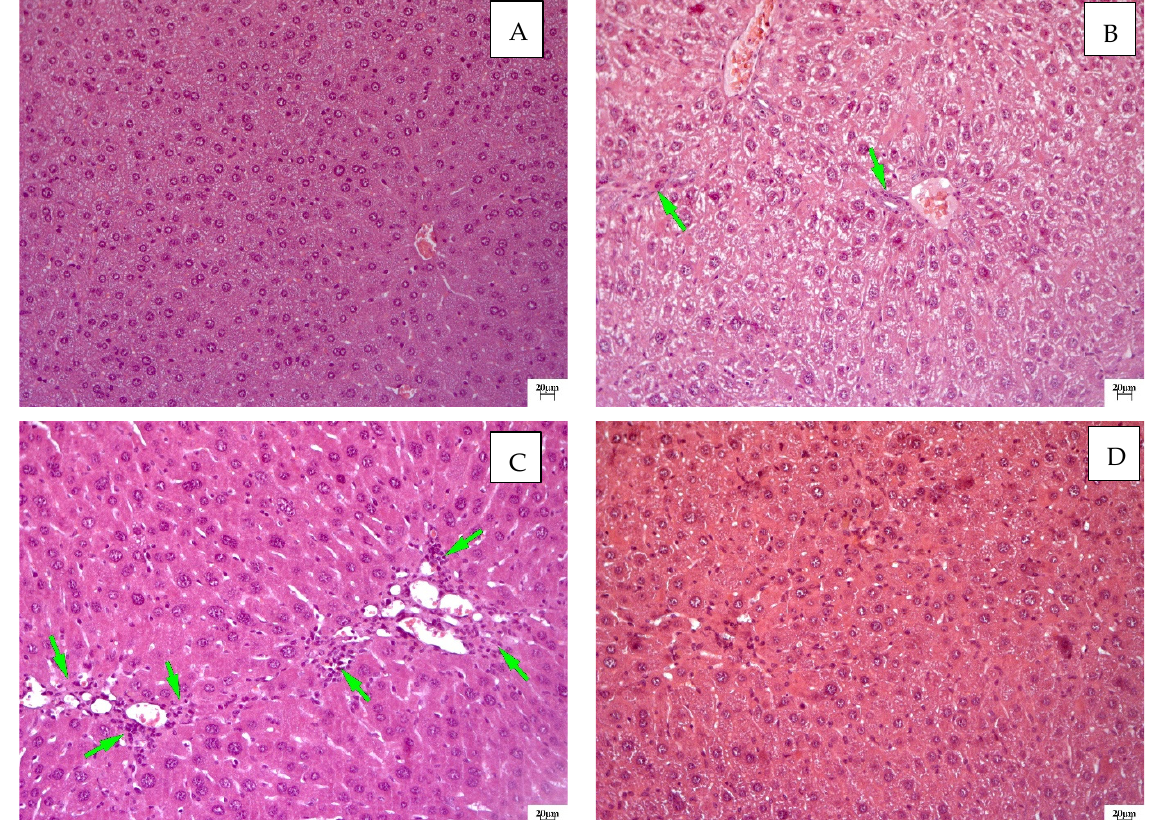
Figure 2. Histological examination of mouse livers after 3 weeks of the experiment: ( A ) Healthy control. In hepatocytes—small vesicular lipid infiltration and heterogeneity of the hepatocyte population: differences in the size of cells and nuclei. Staining with hematoxylin–eosin, ×200. ( B ) Mice treated with CCl 4 alone. Hydropic degeneration and necrosis of hepatocytes. Green arrows indicate necrosis of hepatocytes. Staining with hematoxylin–eosin, ×200. ( C ) Mice treated with CCl 4 alone. Lymphocyte-infiltrated periportal necrosis, fatty infiltration, and hepatocyte population heterogeneity: differences in cell and nuclear size. Green arrows indicate necrosis of hepatocytes. Staining with hematoxylin–eosin, ×200. ( D ) Mice treated with silymarin 100 mg/kg and CCl 4 . Small vesicular degeneration of hepatocytes, thin threads of connective tissue and absence of cellular and nuclear polymorphism of hepatocytes. Staining with hematoxylin–eosin, ×200. Chronic toxic liver damage was detected in animals in the negative control